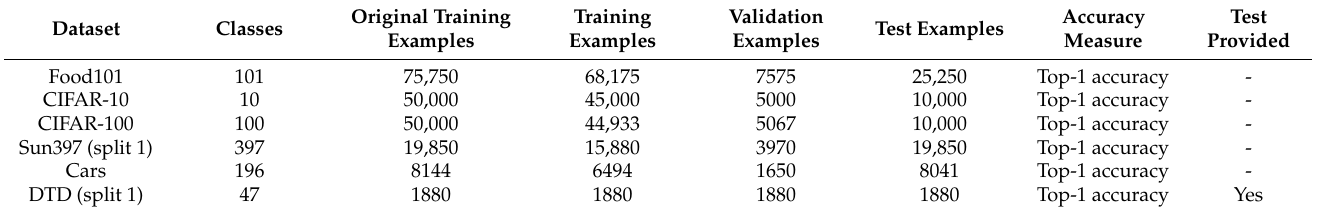
Table A2. The different image datasets used in transfer learning. When an official test split with labels is not publicly available, we use the official validation split as a test set and create a held-out validation set from the training